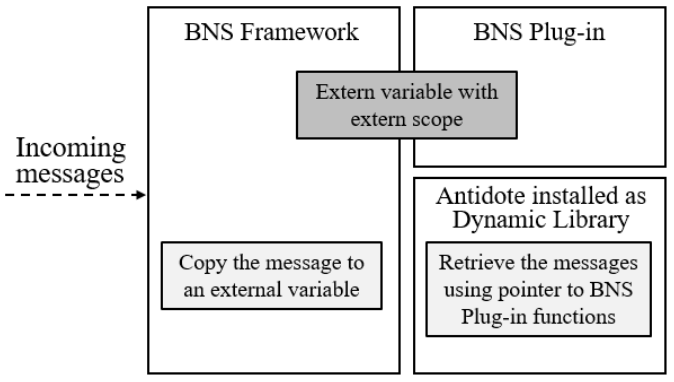
Figure 6. How Antidote Library receives messages from the BNS Framework.